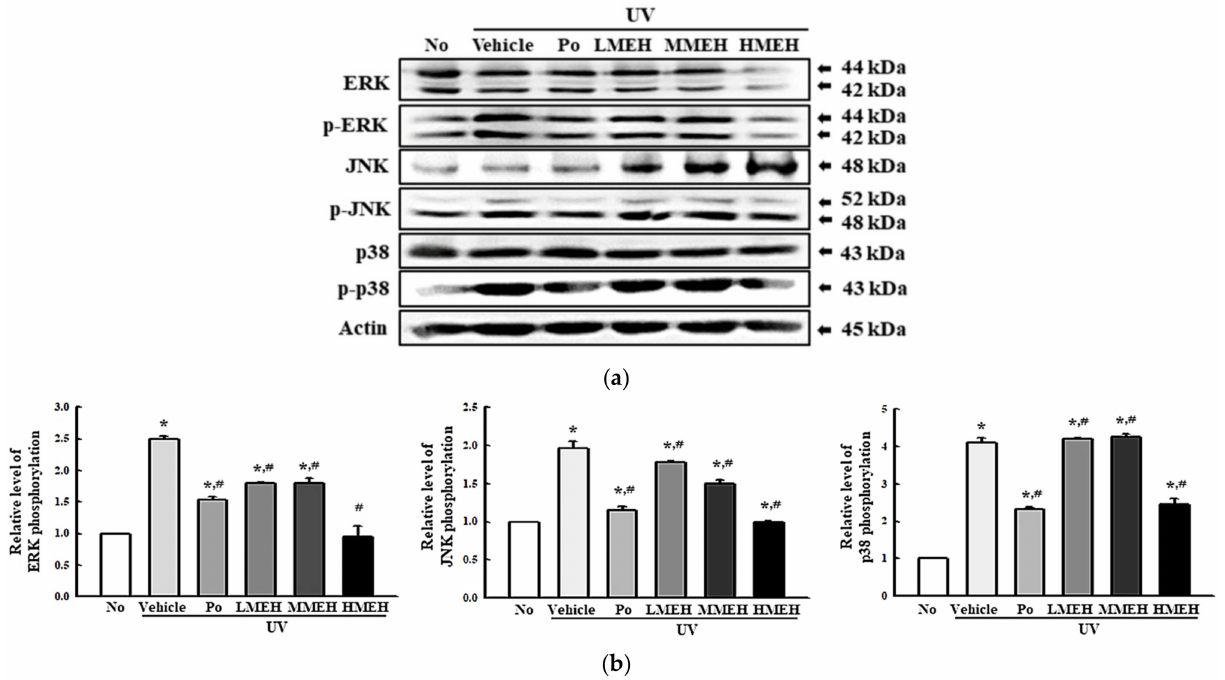
Figure 9. Expression of the key members in the MAPK pathway in normal human dermal fibroblasts. ( a ) Image of western blot. ( b ) Relative level of each protein. Three dishes per group were used to prepare the cell lysates. Western blot was performed in triplicate. This experiment was performed for three times and results are the average of all experiments. The data are reported as the means ± SD of triplicate determinations. *, p < 0.05 compared to the untreated group. #, p < 0.05 compared with the UV + Vehicle group. Abbreviations: MAPK, Mitogen-activated protein kinases; ERK, Extracellular- signal-regulated kinase; JNK, Jun N-terminal kinase; Positive control; MEH, Methanol extracts of Hygrophila erecta (Brum. F.)